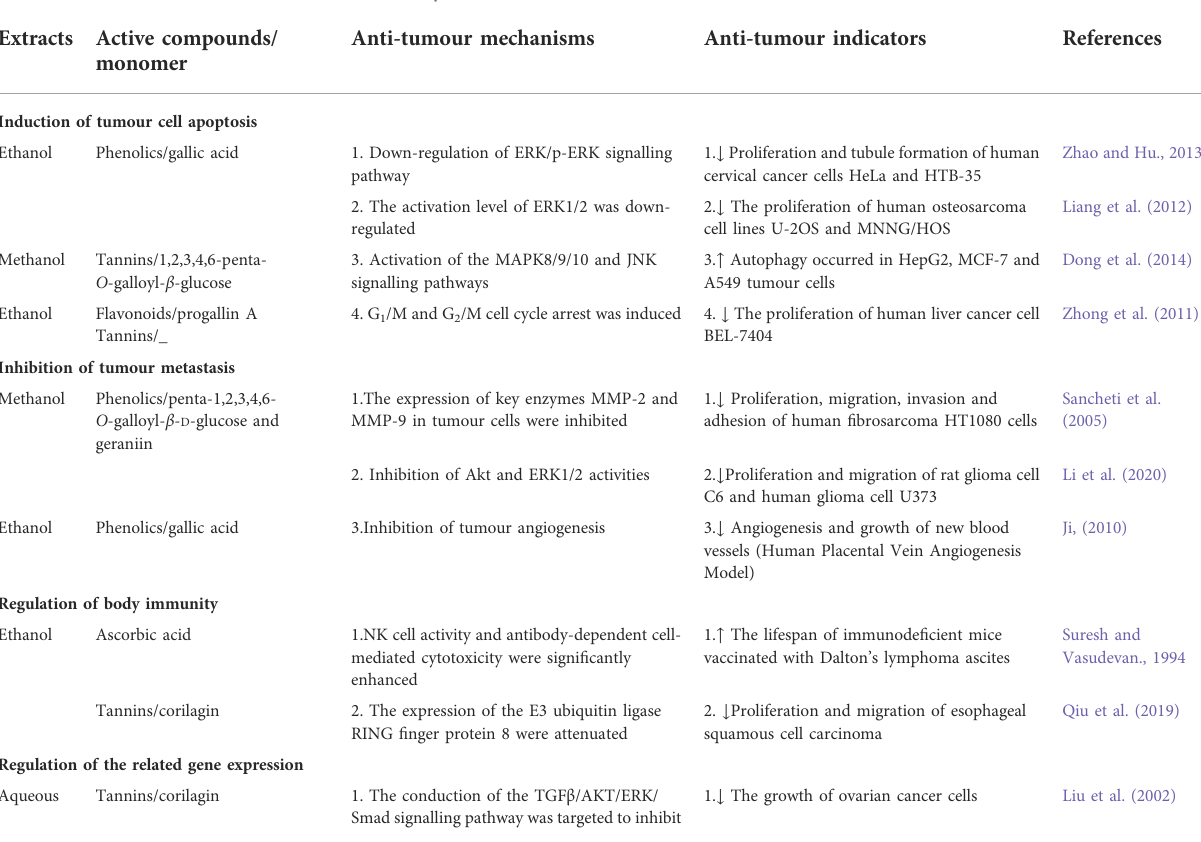
TABLE 3 The anti-tumour mechanisms of active components in PF